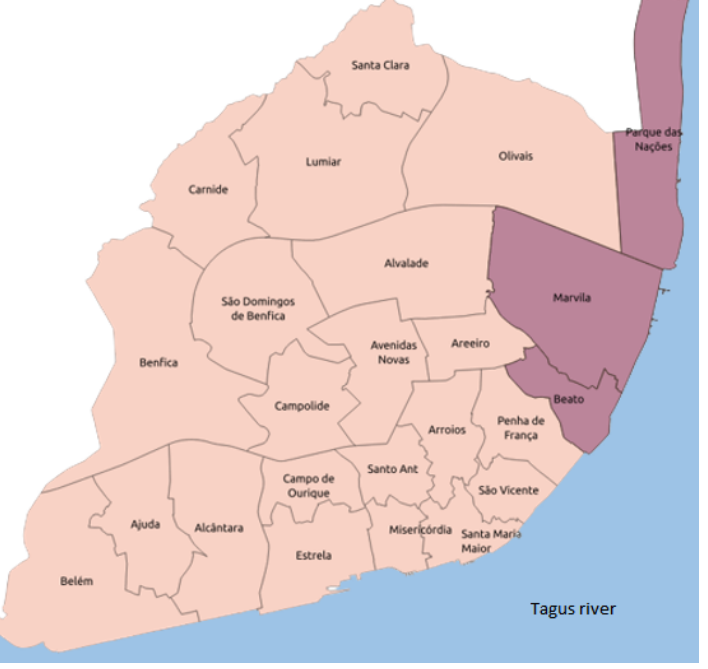
Figure 2. Map of Area of Interest (AoI)— Beato , Marvila , and Parque das Nações